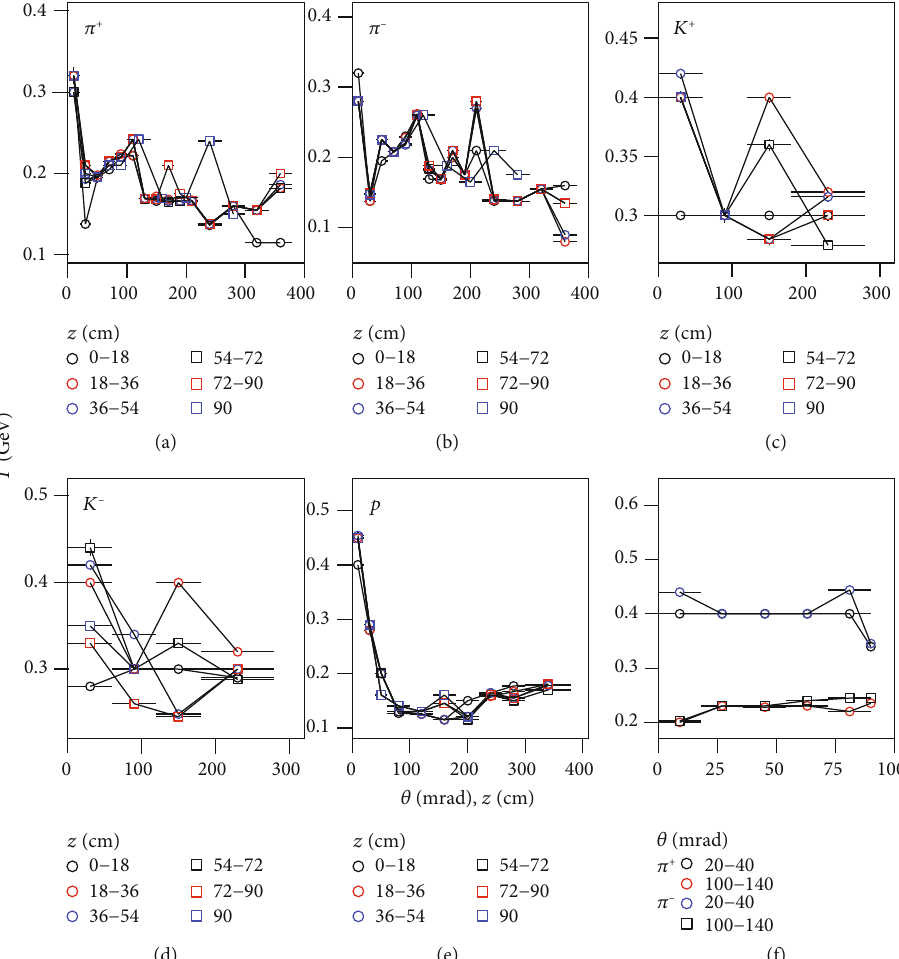
Figure 7: Dependence of T on (a – e) θ , which are extracted from the data samples within di ff erent z ranges for π + , π − , K + , K − , and p , respectively, and on (f) z , which are extracted from the data samples within di ff erent θ ranges for π + and π −